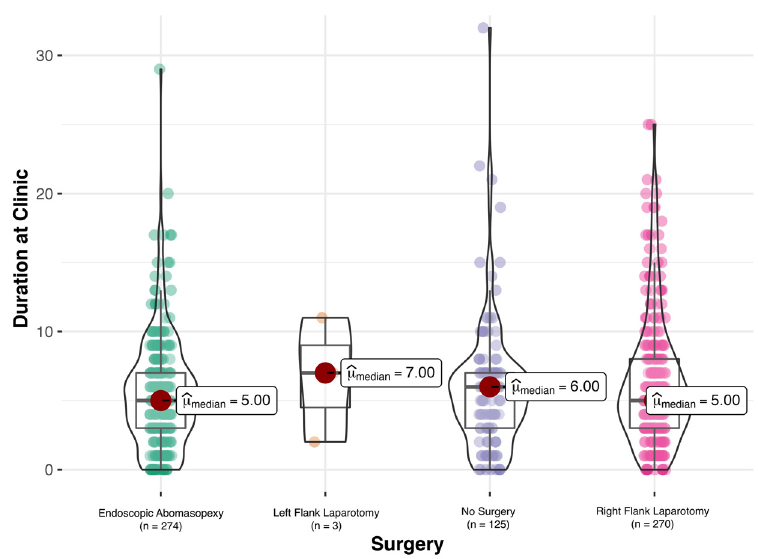
Figure 1. Duration of time spent at the clinic in days according to method of surgery for cows diagnosed with left displacement of the abomasum (LDA). Median numbers for days spent at the clinic were 5 days for endoscopic abomasopexy, 7 days for left flank laparotomy, 6 days for no surgery, and 5 days for right flank laparotomy. There was no significant difference for the numbers of days spent at the clinic for the different methods of surgery.